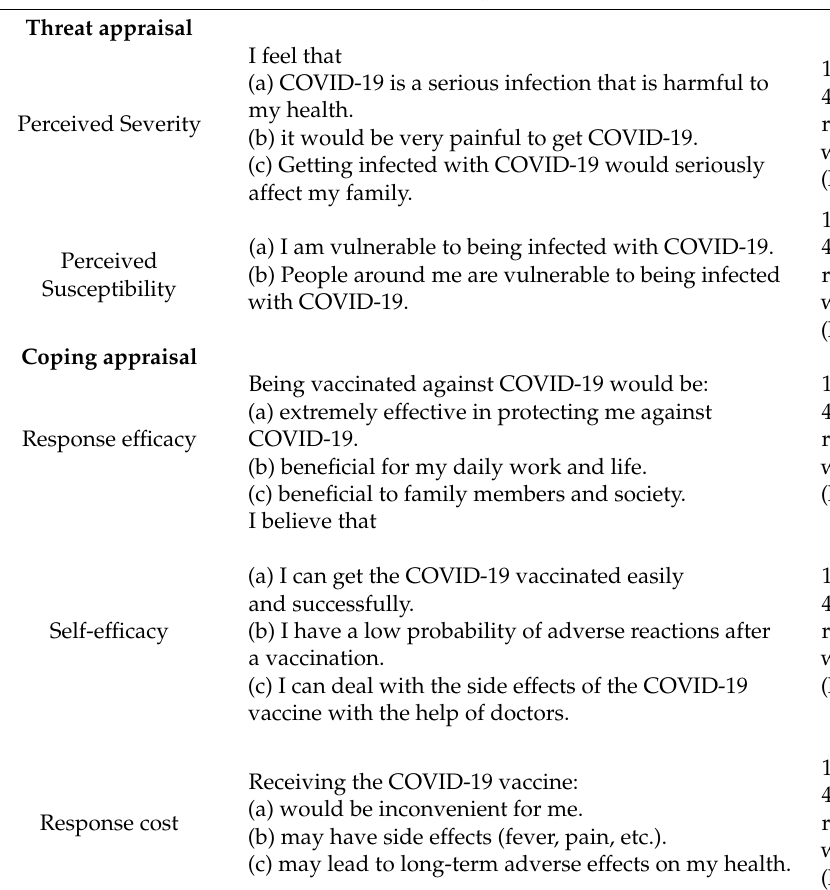
Table 1. Items used to assess the constructs and the factor analysis results of the protection motivation theory (PMT) factors of willingness to get the COVID-19 vaccine. PMT